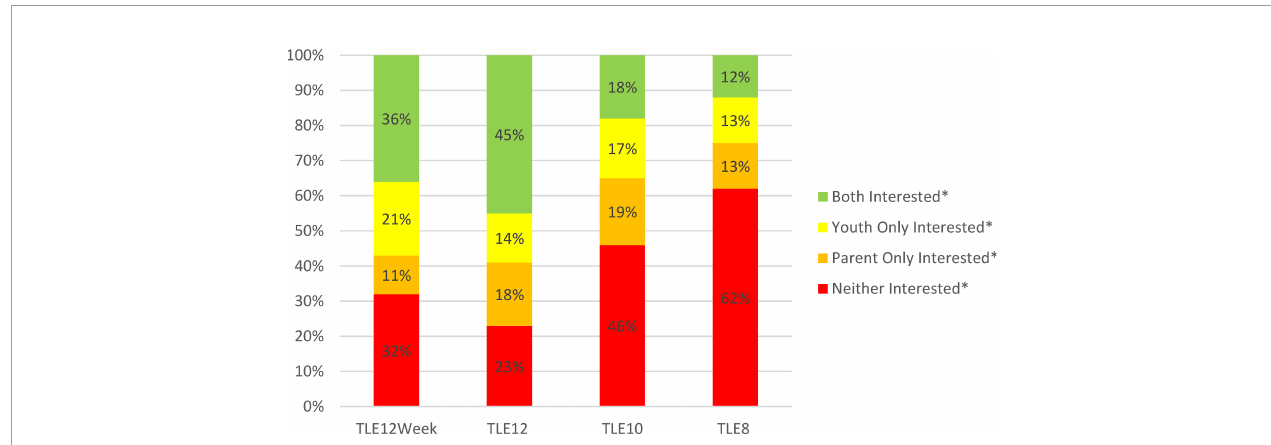
FIGURE 1 | Combined Interest in Time-Limited Eating among Youth 11 to 17 years old and their Parents (n = 146). TLE12Week, Interest in time-limited eating for 12 hours per day on all days of the week; TLE12, Interest in time-limited eating for 12 hours per day on school days; TLE10, Interest in time-limited eating for